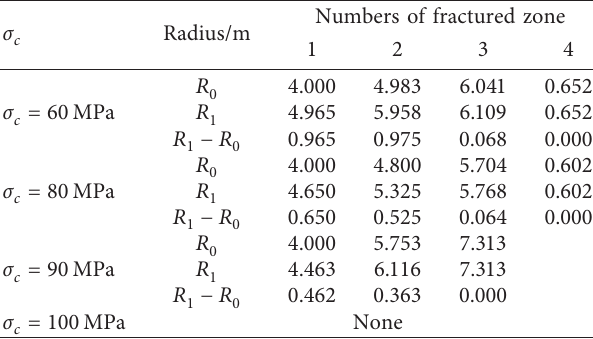
Table 2: The width and quantity of fractured zone when excavation time is 100s [35].